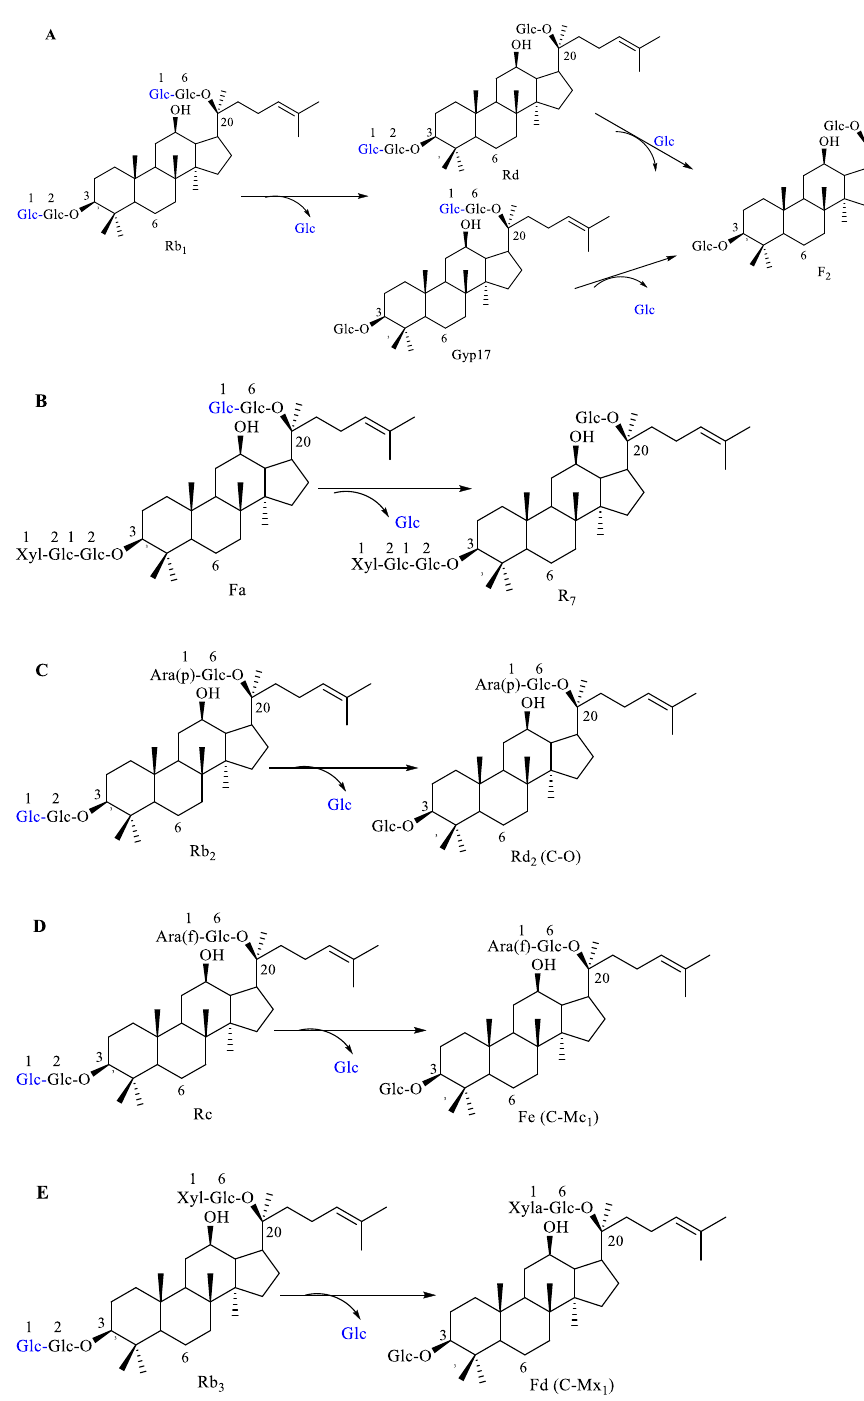
Figure 4. The proposed biotransformation pathways ( A – E ) of ginsenosides Rb 1 , Rb 2 , Rb 3 , and Rc and notoginsenoside Fa by C. xylophilum .